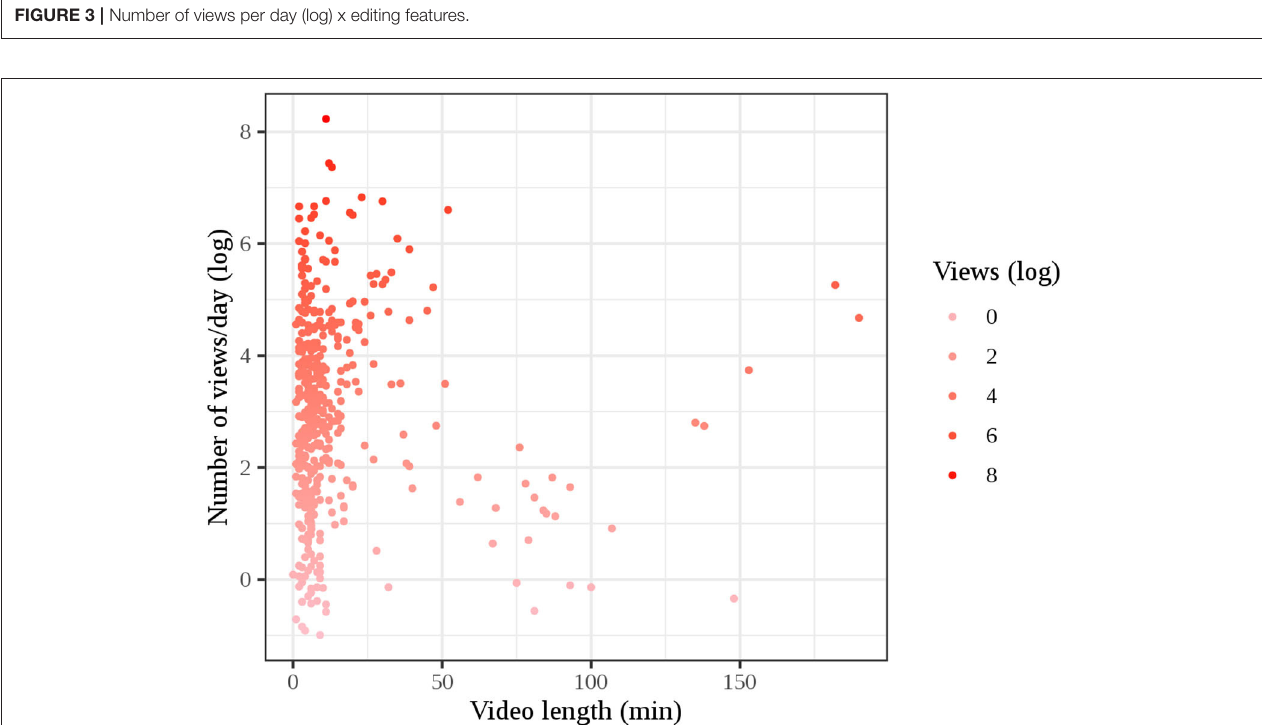
FIGURE 3 | Number of views per day (log) x editing features.